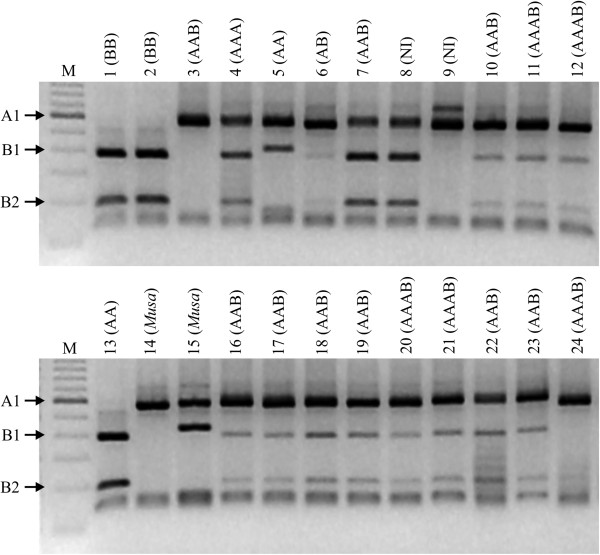
Restriction profile of the amplified ITS regions from Musa accessions with distinct genomic composition. Amplification products of the ITS1-5.8S-ITS2 region after digestion with RsaI. Accessions 1: ‘Butuhan’; 2: BB‘Panamá’; 3: ‘Figue Rose Naine’; 4: ‘Tugoomomboo’; 5: ‘Madu’; 6: ‘PachaNadan’; 7: ‘Njok Kon’; 8:‘Marmelo’; 9: ‘Lareina BT100’; 10: ‘PisangCeylan’; 11:‘PV42-114’; 12:‘PV03-76’; 13: ‘Diplóide Bélgica’; 14:Musa laterita; 15: ‘Musa Royal’ (M. ornata x M. velutina); 16:‘Prata Ponta Aparada’; 17:‘Chifre Vaca’; 18: ‘Pulut’; 19: ‘Pratão’; 20:‘Pacovan Ken’; 21:‘Garantida’; 22: ‘Kelat’; 23:‘Java IAC’; 24: ‘BRS Tropical’. Genomic composition determined by morphology is between parentheses. NI no information on genome composition; (Musa): accession from Rhodochlamys; M: 100 bp ladder marker. Arrows point to fragments of 530 bp specific for A genome (A1); 350 and 180 bp specific for the B genome (B1 and B2).